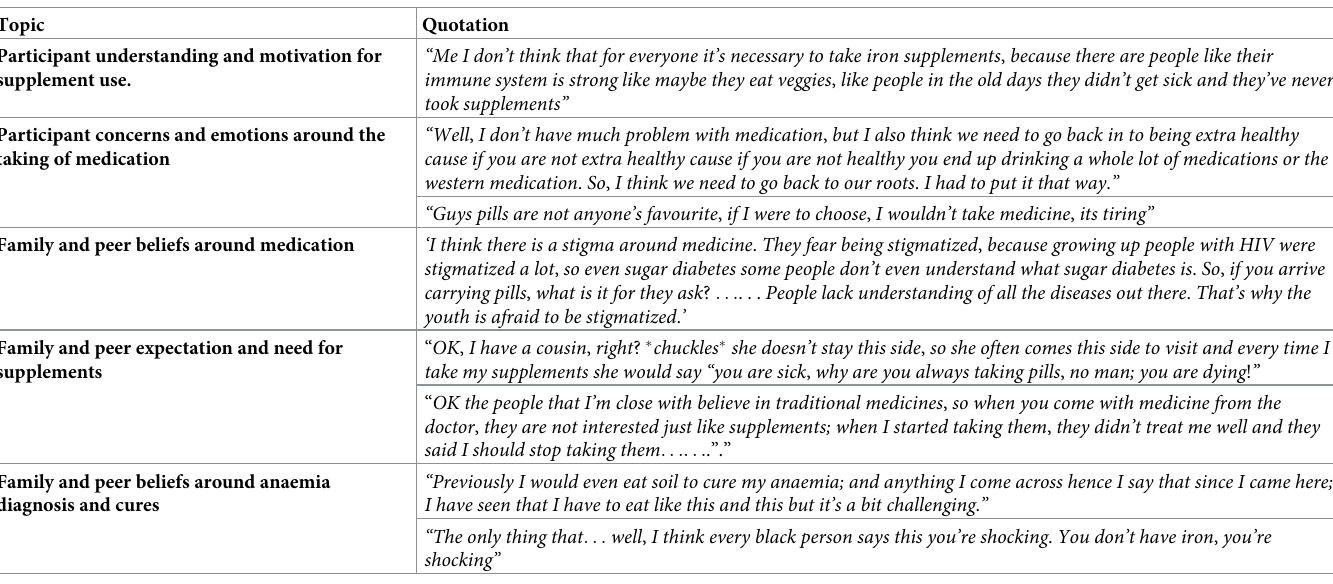
Table 3. Medication related